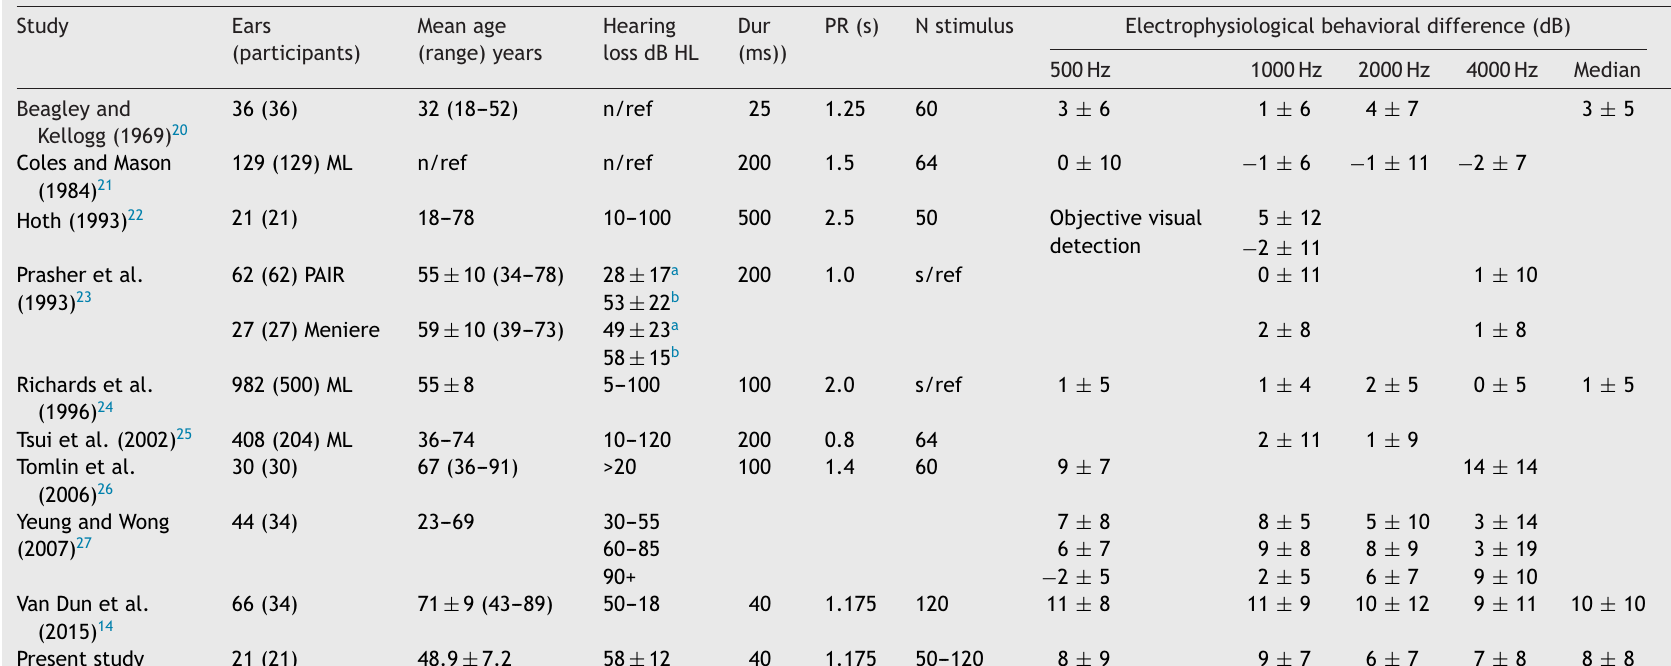
Overview of studies performed with adults with hearing loss for behavioral auditory threshold assessment using